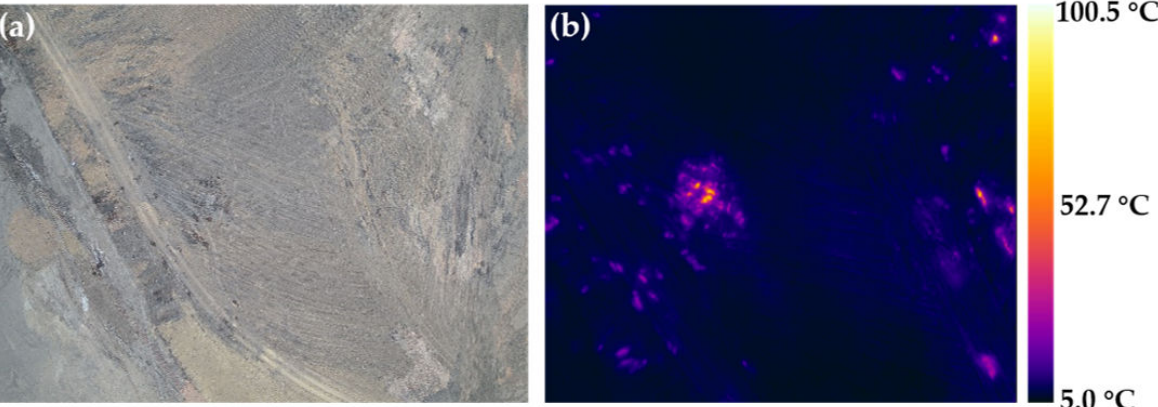
Figure 2. Visible and thermal infrared images synchronously acquired by a UAV: ( a ) visible image and ( b ) thermal infrared